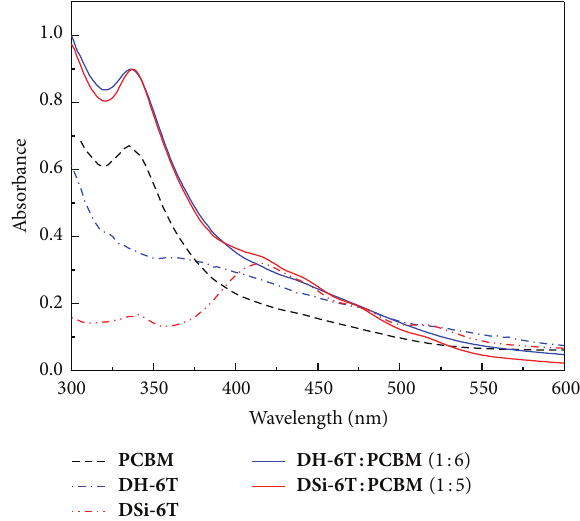
Figure 2: UV-vis absorption spectra of the DSi-6T: PCBM (1:5 w/w) and DH-6T:PCBM (1:6 w/w) blend